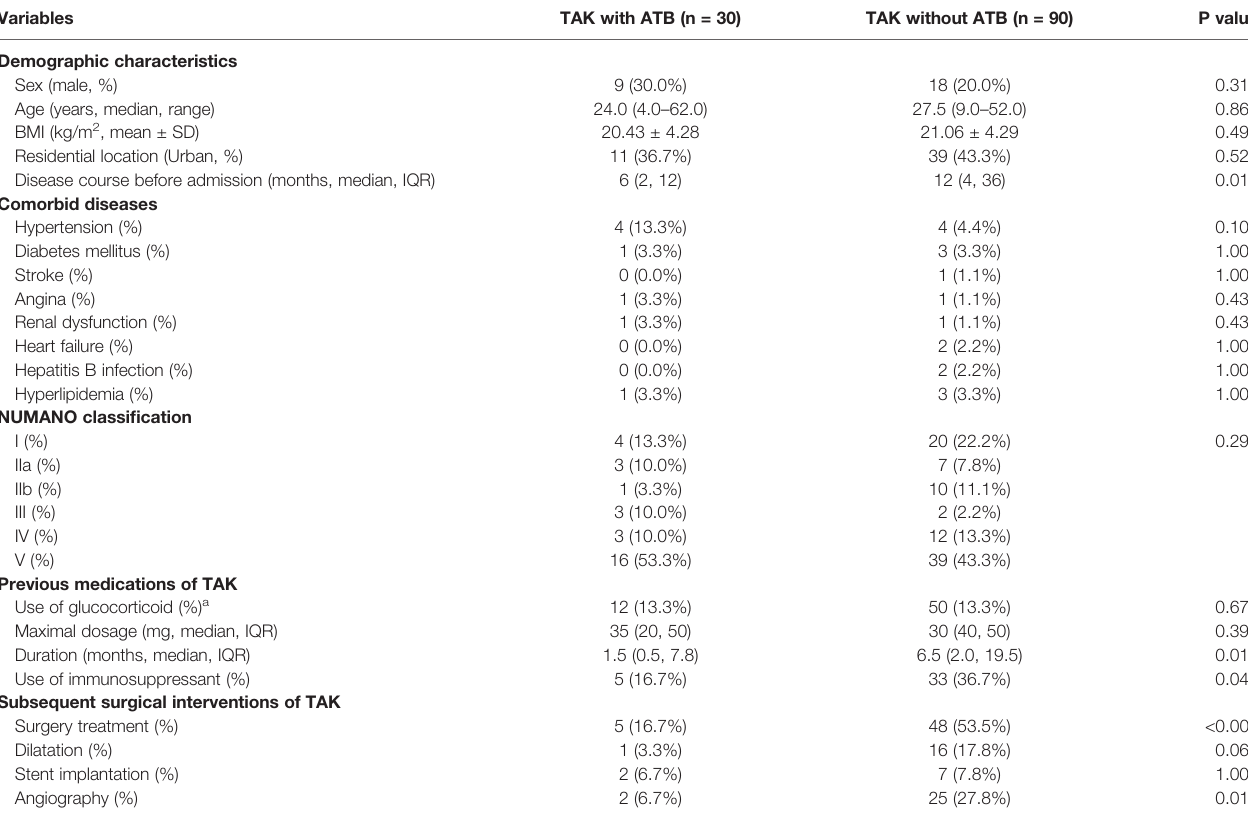
TABLE 1 | Patient characteristics and management of TAK patients with and without ATB.